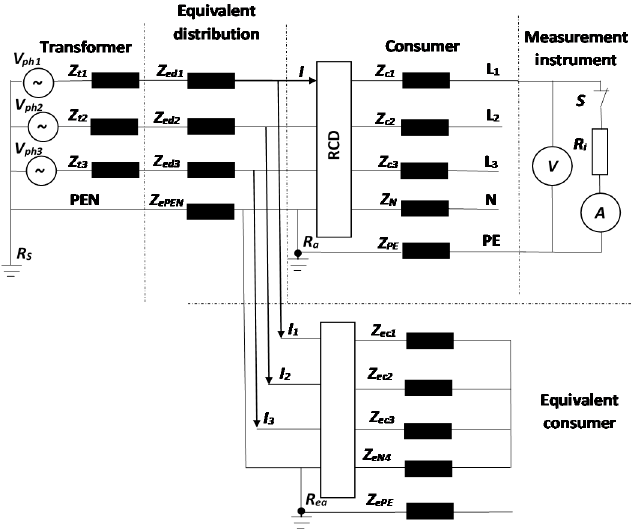
Figure 3. Complete equivalent circuit during earth fault loop impedance measurement.